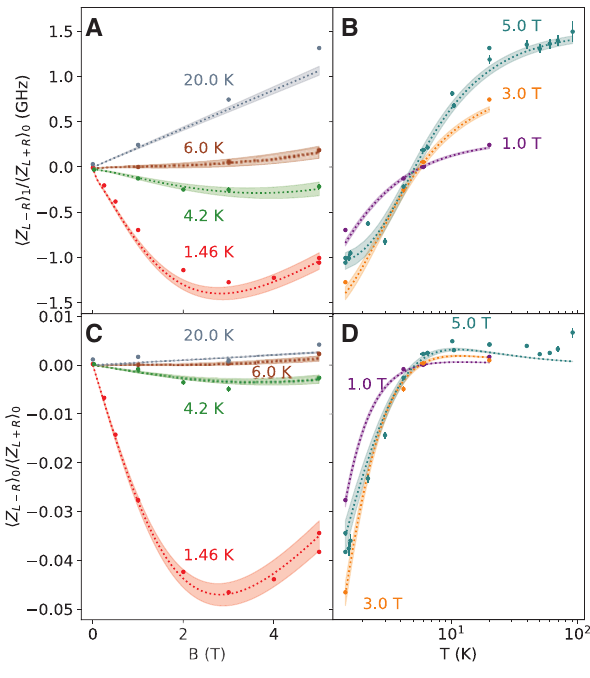
Figure 3: Summary of the MCD results. The MCD values from (6) for varying magnetic field (A) and temperature (B). MCD values from (5) for varying magnetic field (C) and temperature (D). The points represent the values from curve fitting, the moment analysis points are removed for clarity. The dashed curve is the Hamiltonian model using the average parameter values, λ = 2.24 ± 0.05 GHz and l = 0.0186 ± 0.0005, the shaded regions represent the 1 σ uncertainty in the average parameter